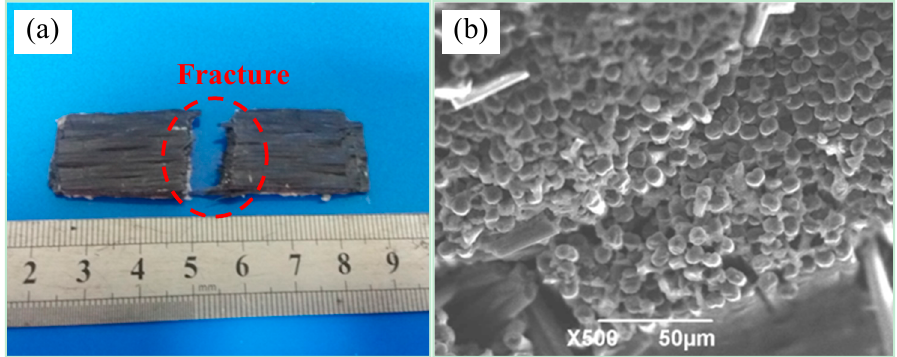
Figure 8. The defect of brittle fracture of 2D-T700/E44 composite prepared by ICM. ( a ) Macrostructure of brittle fracture; ( b ) Micro fracture of brittle fracture.